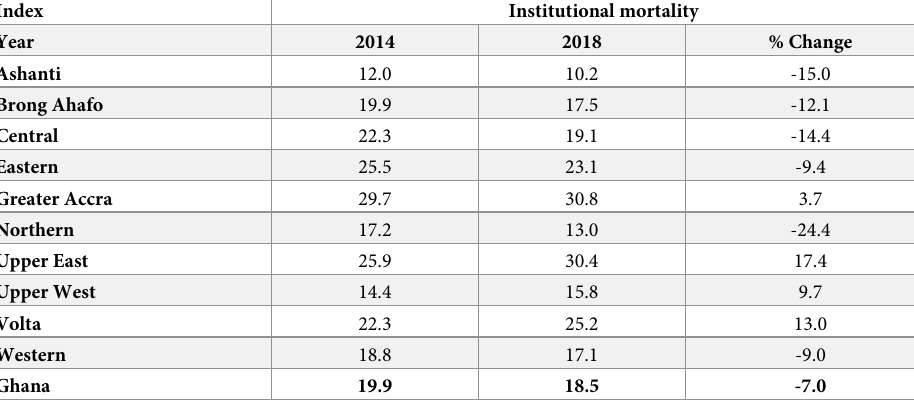
Table 2. Percent change in institutional mortality rate in Ghana between 2014 and 2018, by